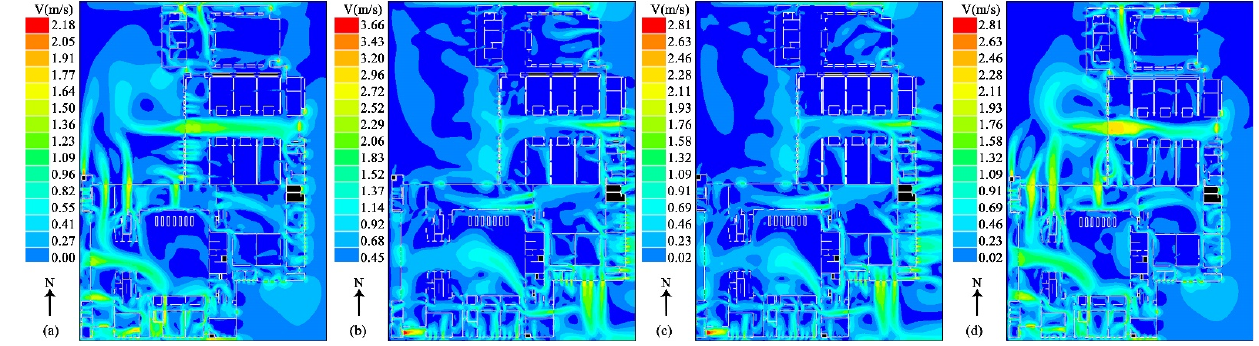
Figure 5. Spatial variation characteristics of inner wind over four seasons, in spring ( a ), summer ( b ), autumn ( c ), and winter ( d ).